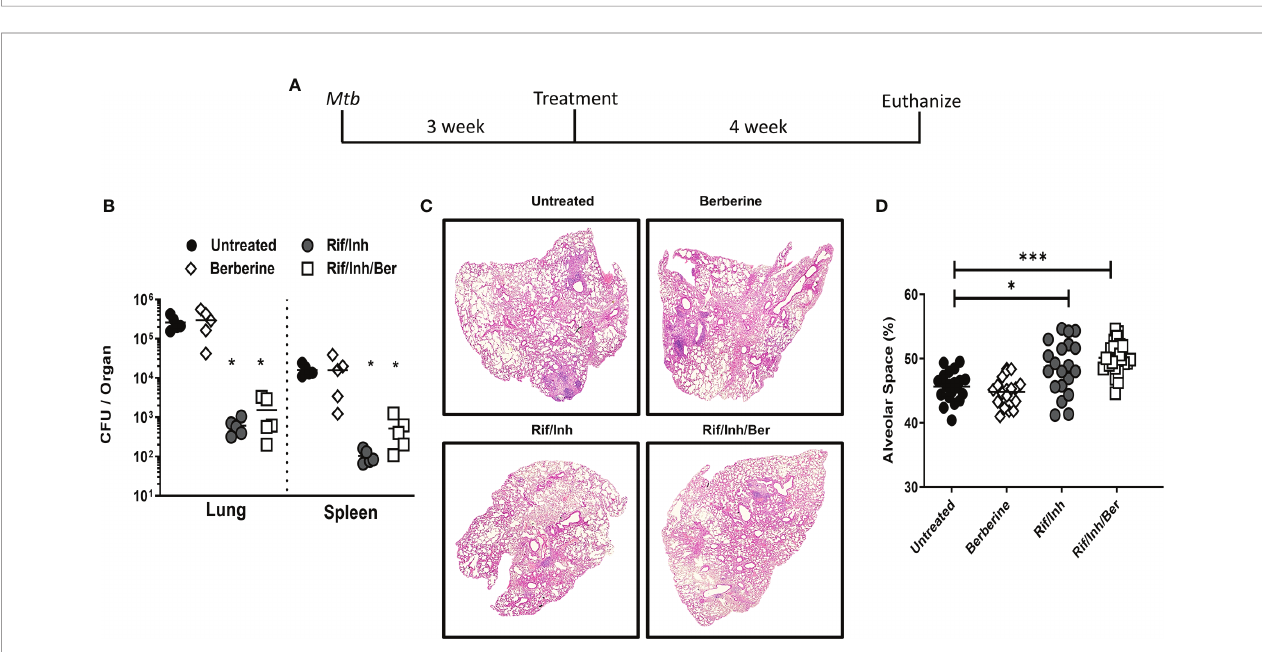
FIGURE 6 | Late-onset of berberine adjunctive therapy against Mtb infection in C57BL/6 mice. (A) Animals were infected with Mtb (100CFU) via aerosol inhalation. After 3 weeks of infection, mice were either left untreated or treated with berberine (1 mg/ml) or rifampin/isoniazid (0.1 mg/ml) and rifampin/isoniazid in combination with berberine in drinking water for 4 weeks as shown in the layout. (B) Mycobacterial burdens in the lung and spleen. (C) Representative lung section for pathology. (D) Quanti fi cation of free alveolar air spaces in the lungs at 4 weeks post-treatment. Data is shown representative of two experiments (n = 5 per group) and the line denotes mean value, analysed by Brown-Forsythe and Welch ANOVA test with Tamhane T2 post-hoc test de fi ning differences in all groups as signi fi cant *P ≤ 0.05; ***P ≤ 0.001. Asterisks without the line below show the signi fi cance compared to the untreated